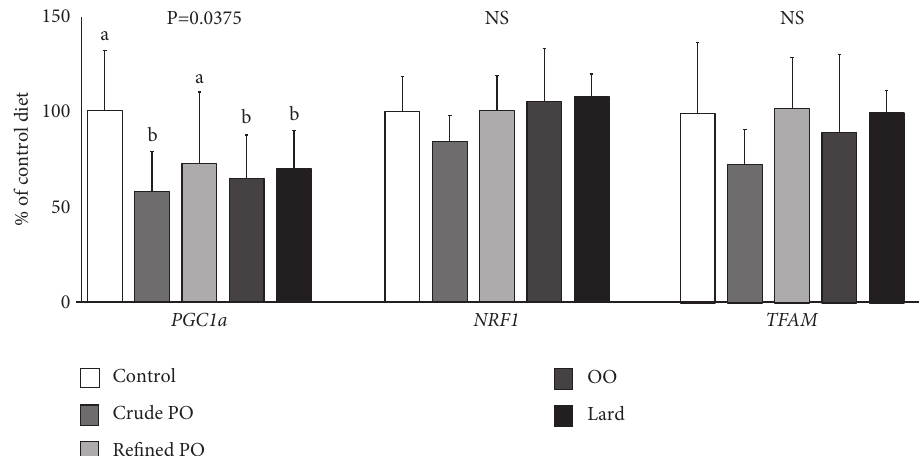
Figure 3: Expression of genes involved in liver mitochondrial biogenesis. Values are expressed as mean ± SD ( n � 7-8). Histogram bars with different letters are significantly different. PO, palm oil; OO, olive oil; Pgc1 α , peroxisome proliferator activator receptor c coactivator-1 α ; Nrf1, nuclear respiratory factor 1; Tfam, mitochondrial transcription factor